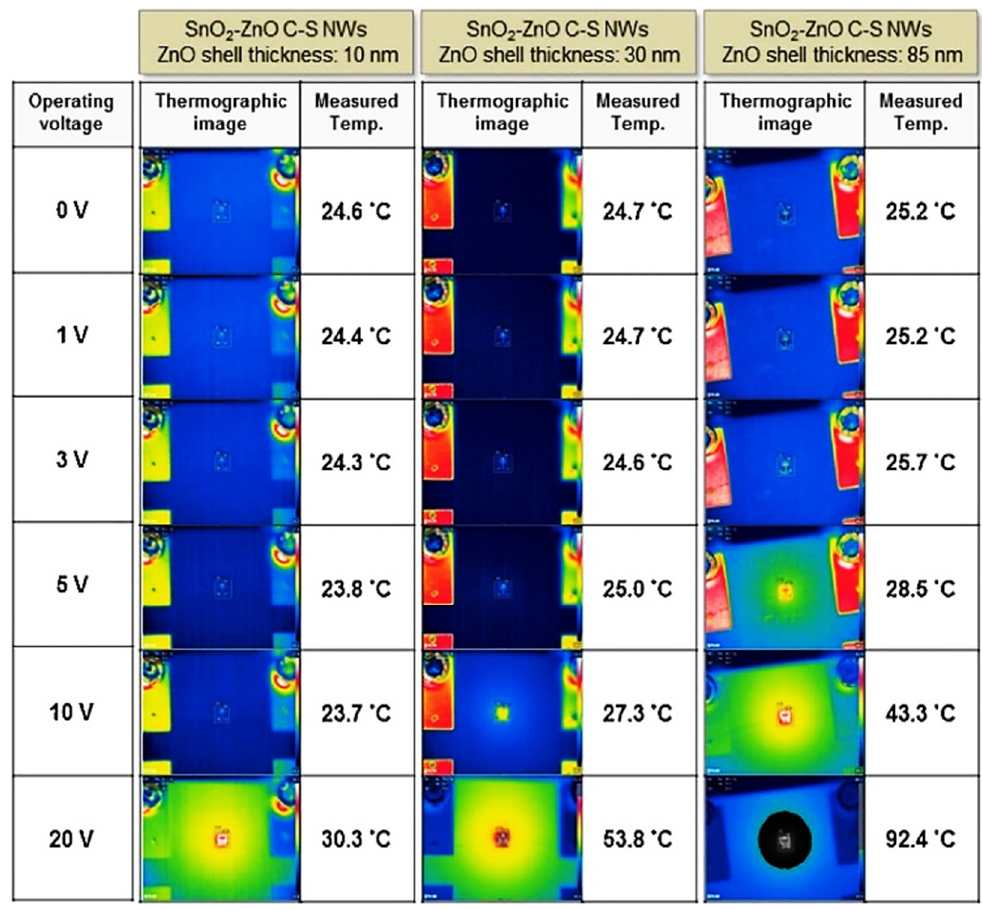
Figure 19. Thermographs of the Pt/SnO 2 -ZnO C-S NW sensor with various shell thicknesses at different applied voltages. Reproduced from [112] with the permission of Elsevier.